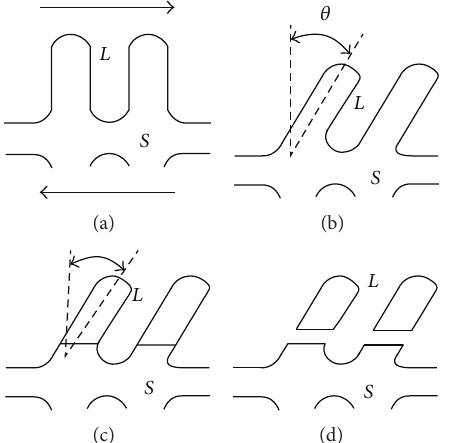
Figure 2: Schematic illustration of the steps of the mechanism of dendrite fragmentation: (a) undeformed dendrite; (b) after bending; (c) formation of high-angle boundary; (d) fragmentation through wetting of grain boundary by liquid metal